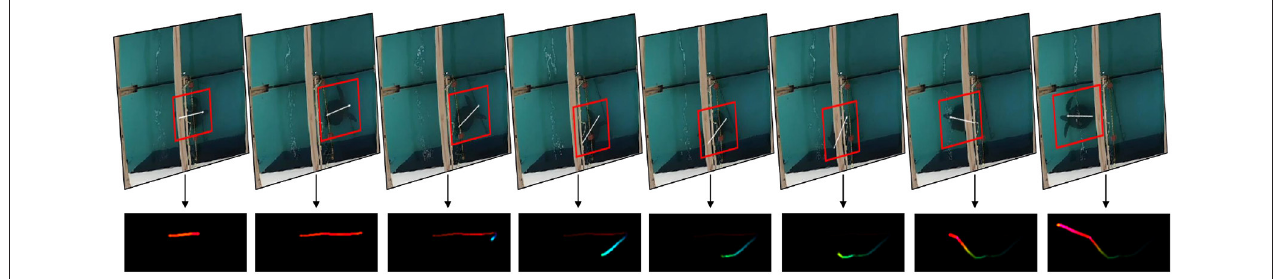
FIGURE 3 | Color coded spatiotemporal feature images generated using turtle velocity vector and orientation information.